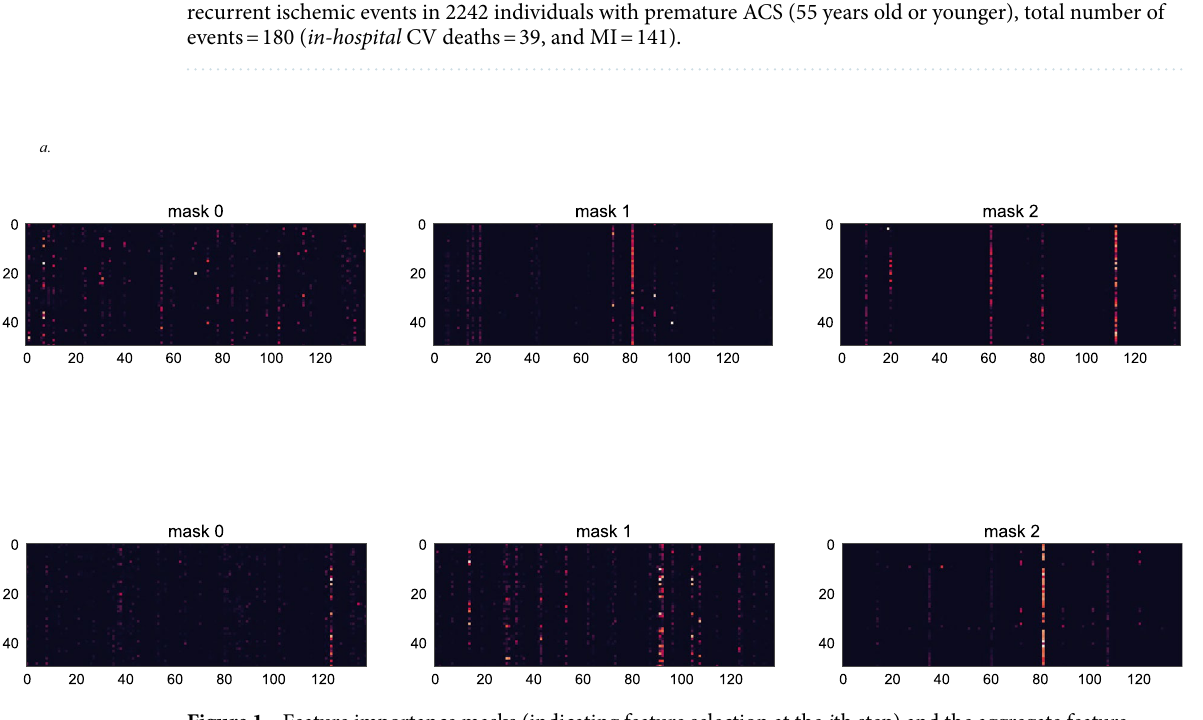
Figure 1. Feature importance masks (indicating feature selection at the i th step) and the aggregate feature importance mask (mask 0) showing the global instancewise feature selection on the global cohort ( a ) and young subjects with ACS ( b ). Brighter colors show higher values. Legend: The x axis represents each feature used in B-CaRe:QCO dataset; and the y axis represents the first 50 test samples. Features shown in vivid/bright colors were more intensely recruited, and features shown in dark colors were less intensely recruited. In the global cohort, 28 variables are recruited by TabNet algorithm, and 20 are responsible for 91% of the model variance. In the yACS cohort, 24 variables were recruited by TabNet algorithm, and 20 were responsible for 93% of the model